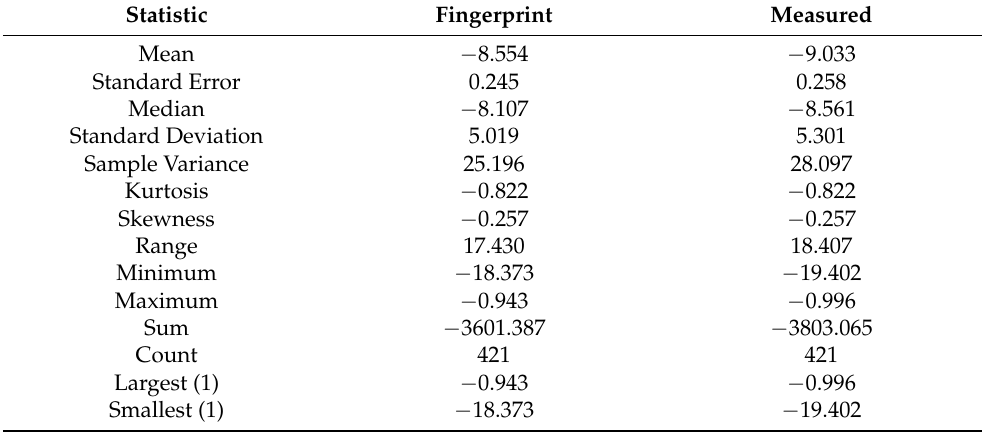
Table 13. Sub-region 1: Descriptive statistics comparison between fingerprint and measured FRA